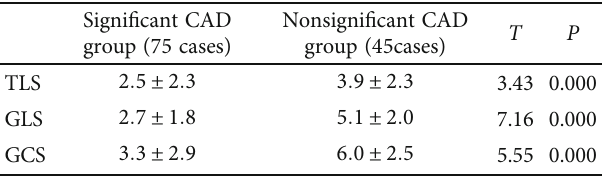
Table 3: Comparison of the di ff erence of strain parameters between 1 week after operation and immediately after operation.